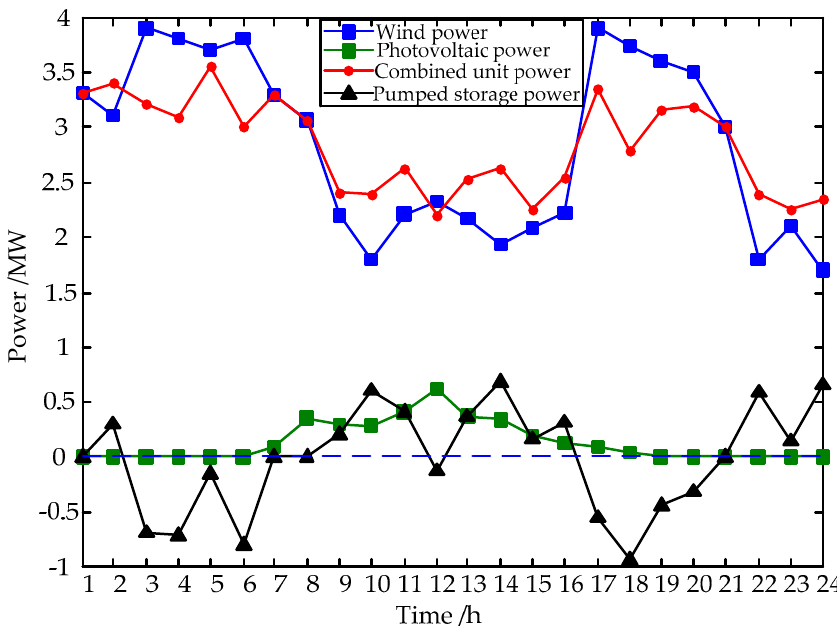
Figure 8. The output curve of each unit after the pumped storage energy flattens on typical day C.